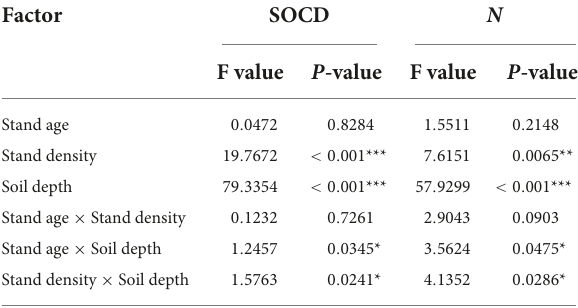
TABLE 2 Analysis results affecting soil carbon and N . In the table, asterisk represents statistical significance. Factor